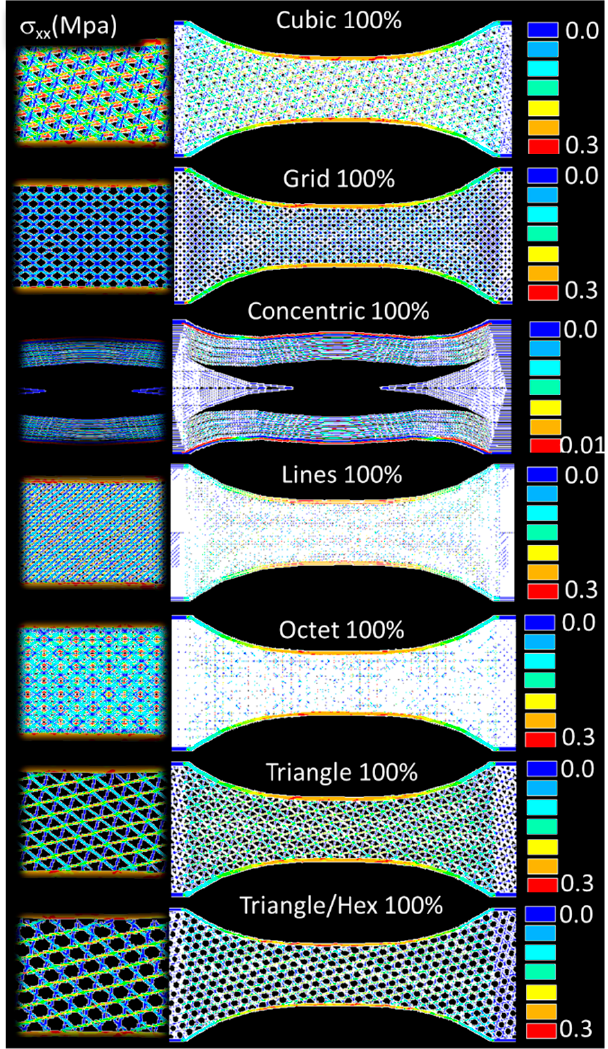
Figure 8. Predicted stress component σ xx field for varieties of airy filling patterns (infill ratio 100%).